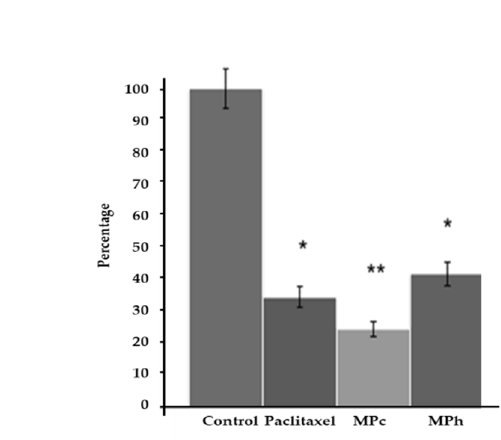
Figure 7. Effect of extracts on PC3 cells migration and invasion. Graphs show 2D horizontal cells migration (ORIS assay, ( left ); cells treated with the MNTC concentration of MPc and MPh for 24, 48, and 72 h); CytoSelect migration assay, ( right ) (cells treated with the MNTC concentration of MPc and MPh for 48 h). The results shown are representatives of three independent experiments. Data are means ± SEMs ( n = 3). * p < 0.05 and ** p < 0.01, as determined via unpaired t